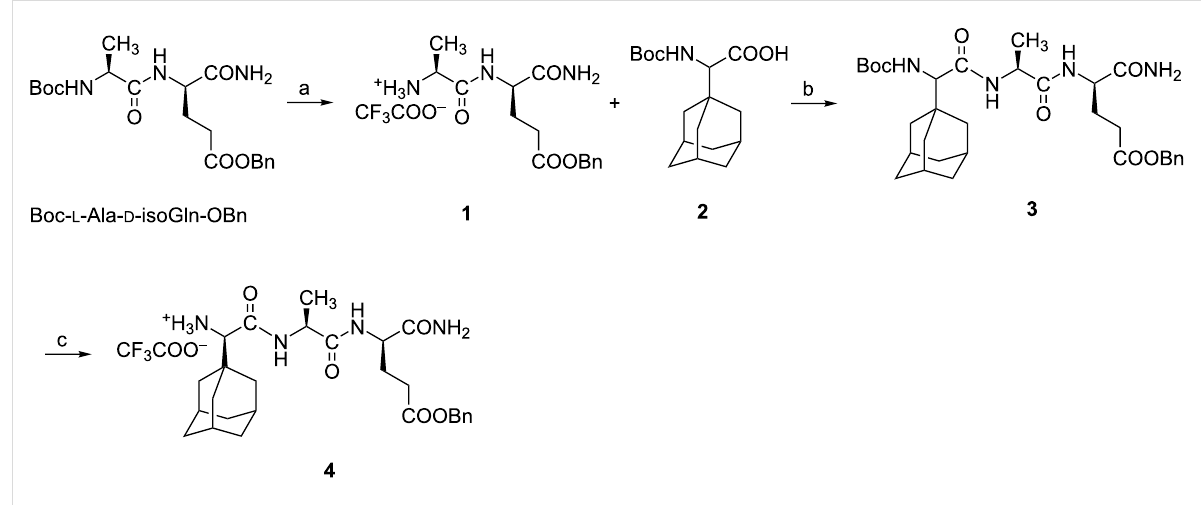
Scheme 1: Synthesis of desmuramyl peptides modified at N-terminus. Reagents and conditions: a) TFA/DCM 1:2, rt, 1 h, quantitative; b) EDC·HCl, HOBt·H